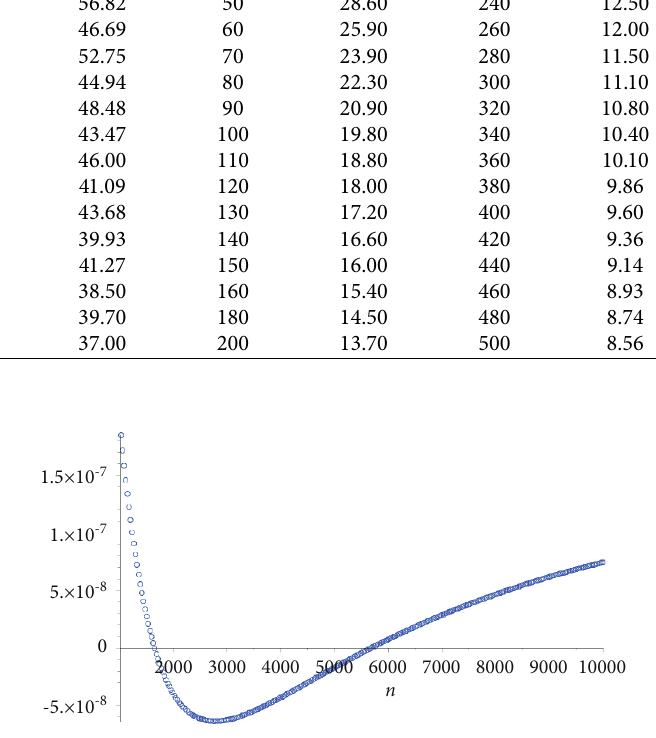
( n ) when 1000 ≤ n ≤ 10000, step 300. 7 a